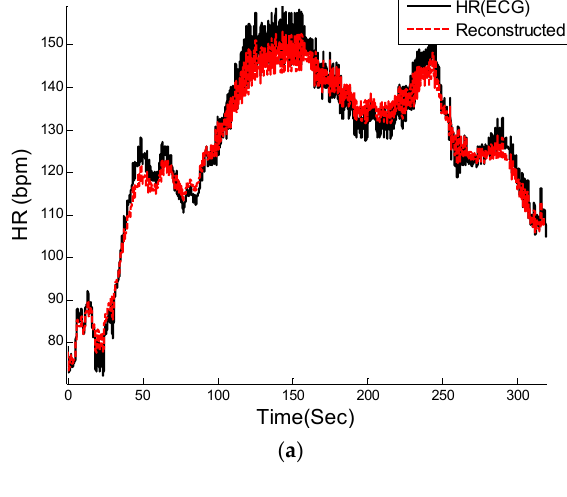
Figure 7. Cont. Figure 7. Cont.